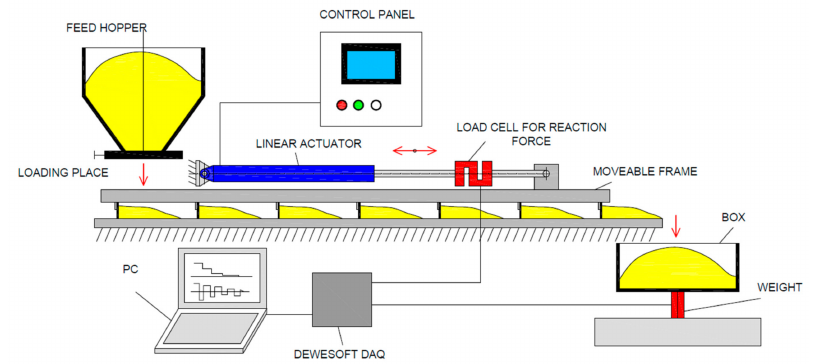
Figure 3. Scheme of the experimental testing equipment with the measuring